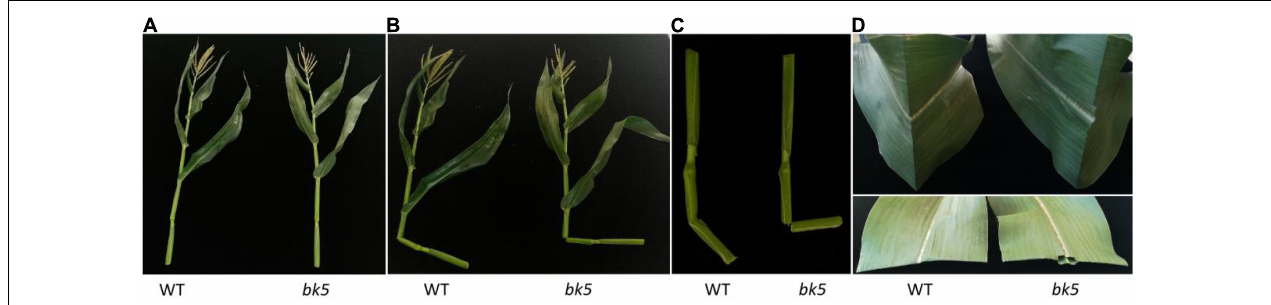
FIGURE 1 | Phenotypes of stalks and leaves of wild-type (WT) and mutant plants at the stage of anthesis. (A) Normal growth conditions. (B) Broken stalks. (C) Enlargement of broken stalks. (D) Broken leaves.